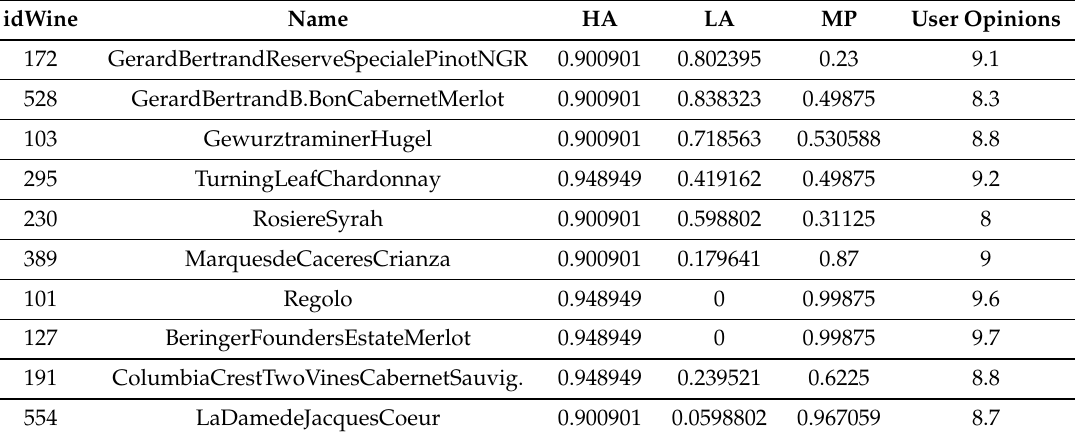
Table 3. Relation values for the individuals and concepts in the wine